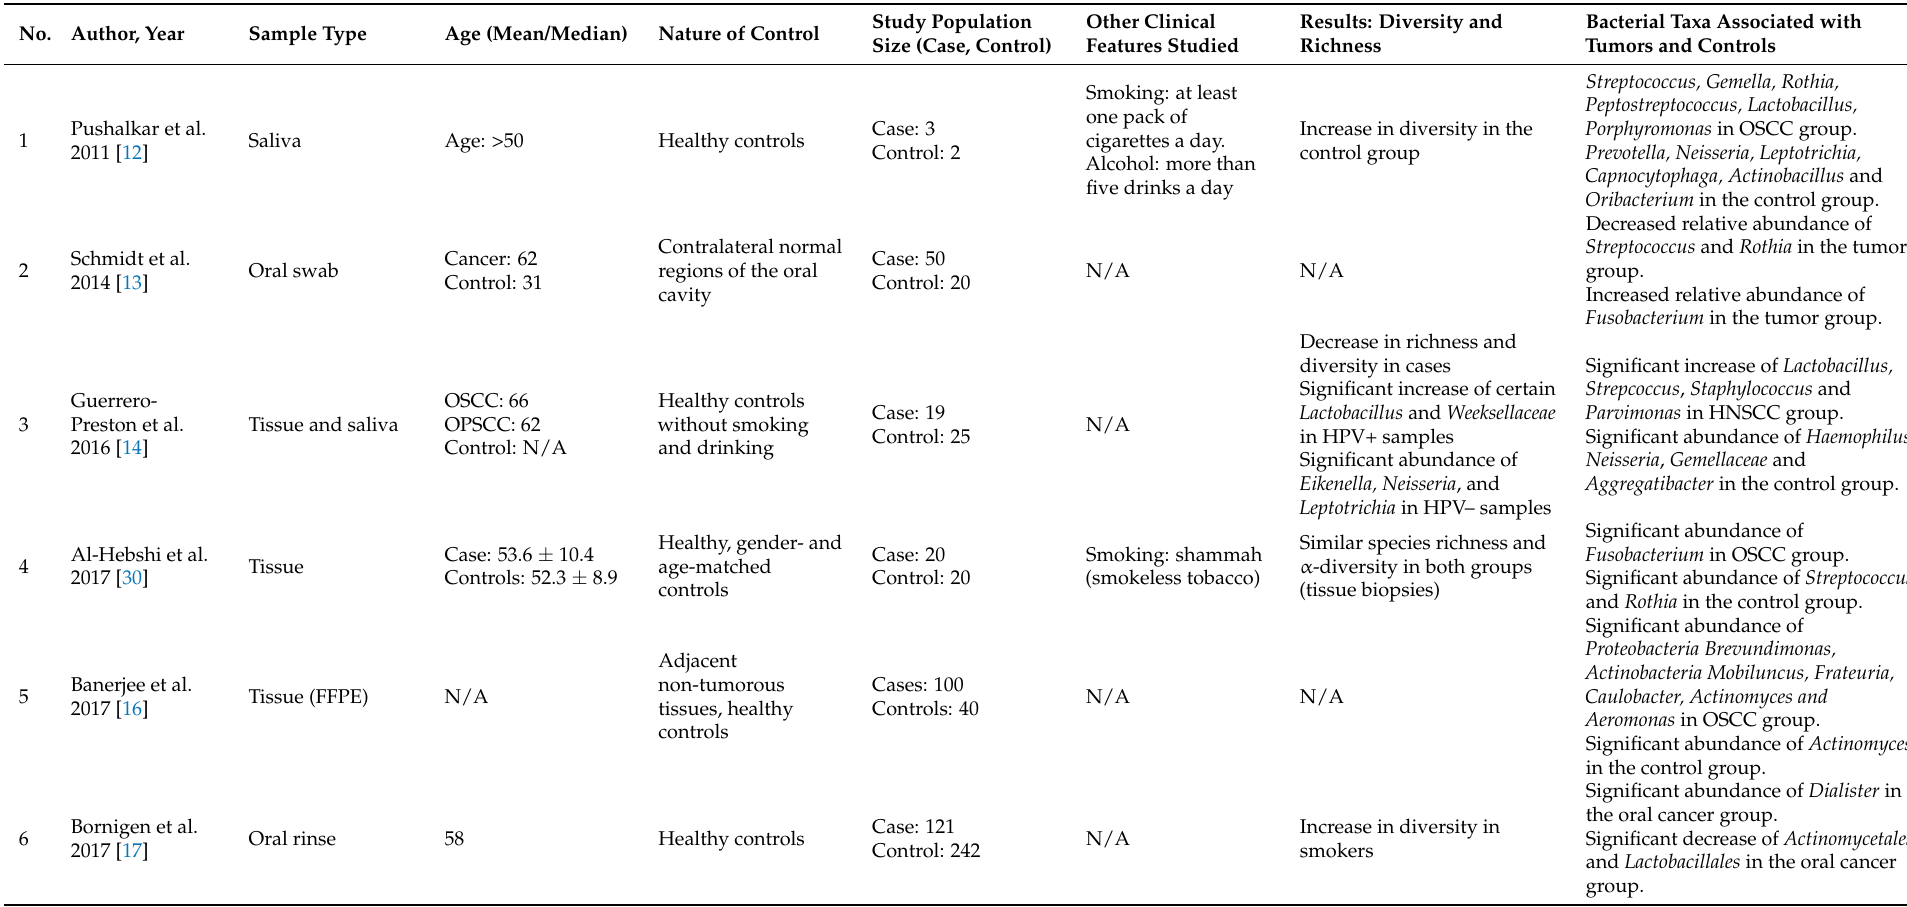
Table 1. Summary of characteristics of epidemiological studies on the microbiome and oral